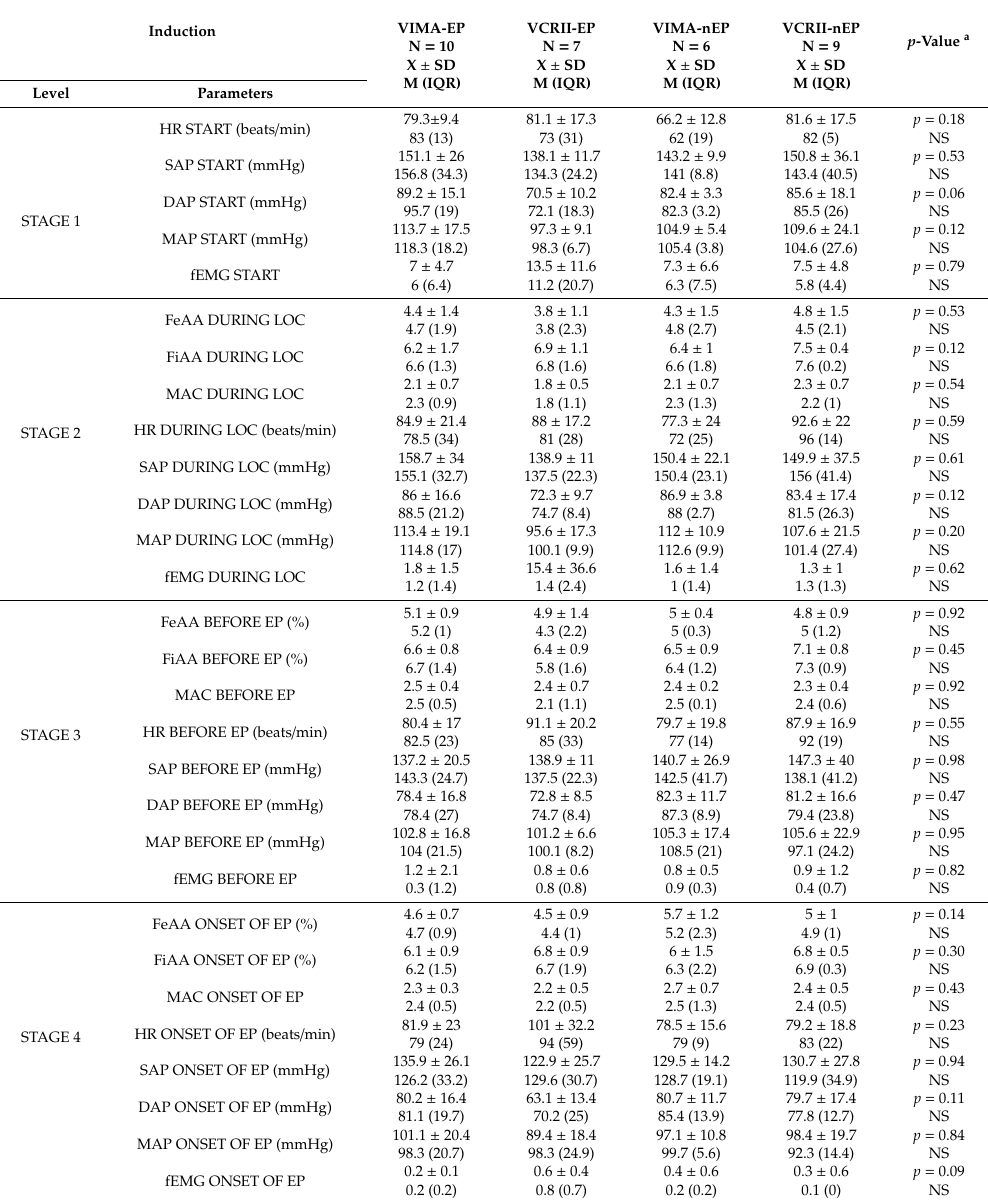
Table A1. Comparison of values of monitored patients’ parameters at the same stage between studied groups. (stage 1: before onset of VIGA, stage 2: after LOC, stage 3: before presence of first epileptiform pattern, stage 4: during presence of epileptiform patterns, stage 5: during the highest values of RE and RE during presence of epileptiform patterns in patients from group VIMA and VCRII, Stage 6: during the highest values of RE and RE after disappearance of epileptiform patterns in patients from group VIMA and